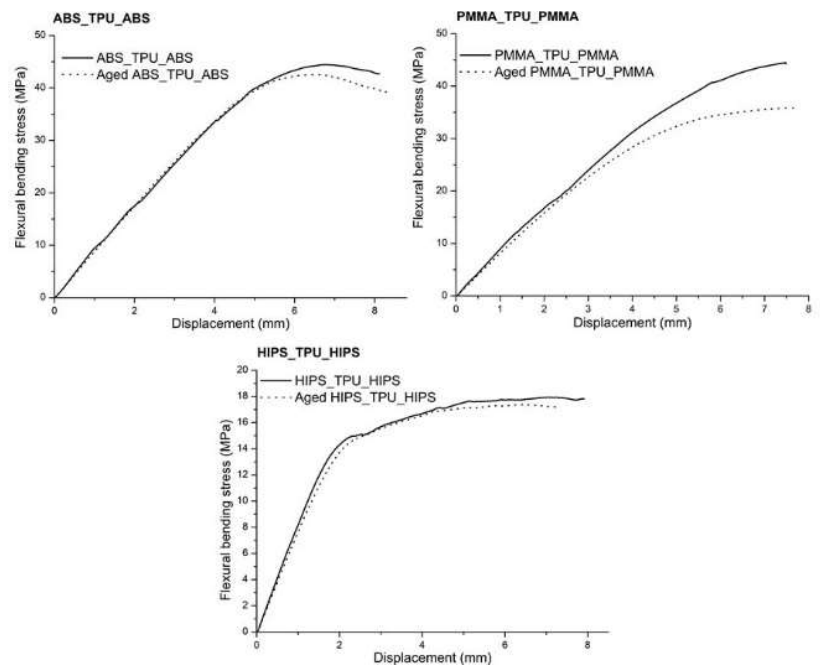
Figure 6. Representative curves of the sandwich structure materials that were obtained using 3PB tests.